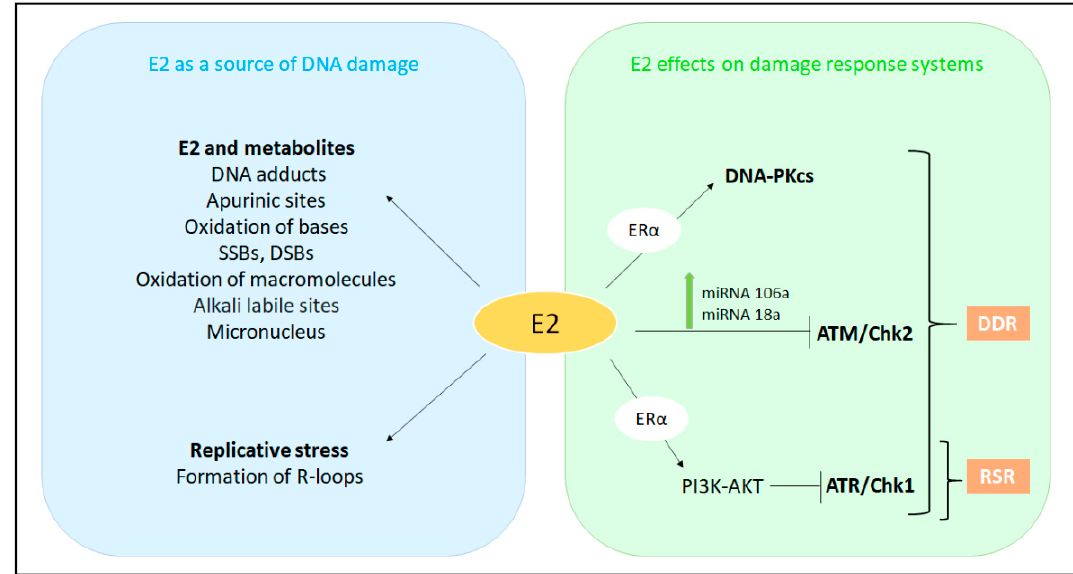
Figure 5. The interplay among E2, E2:ER α signaling and DNA damage, DNA damage response (DDR), and replication stress response (RSR). For details, see the text. 17 β -estradiol (E2); estrogen receptor α (ER α ); catalytic subunit of DNA protein kinases (DNA-PKcs); Ataxia Telangiectasia Mutated (ATM); Ataxia Telangiectasia and Rad3-Related Protein (ATR); Checkpoint Kinase 1 (Chk1); Checkpoint Kinase 2 (Chk2).